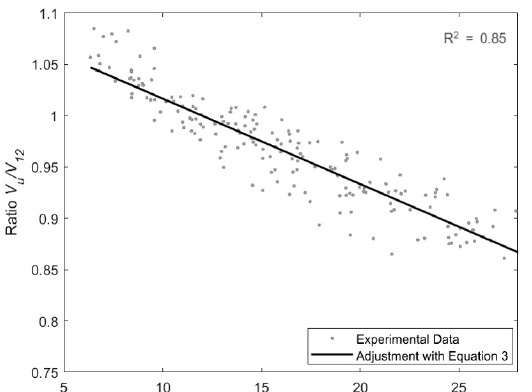
Figure 2. Correlation between MC and relative ultrasound velocity measurement (5%–28%) trend line for Teak.